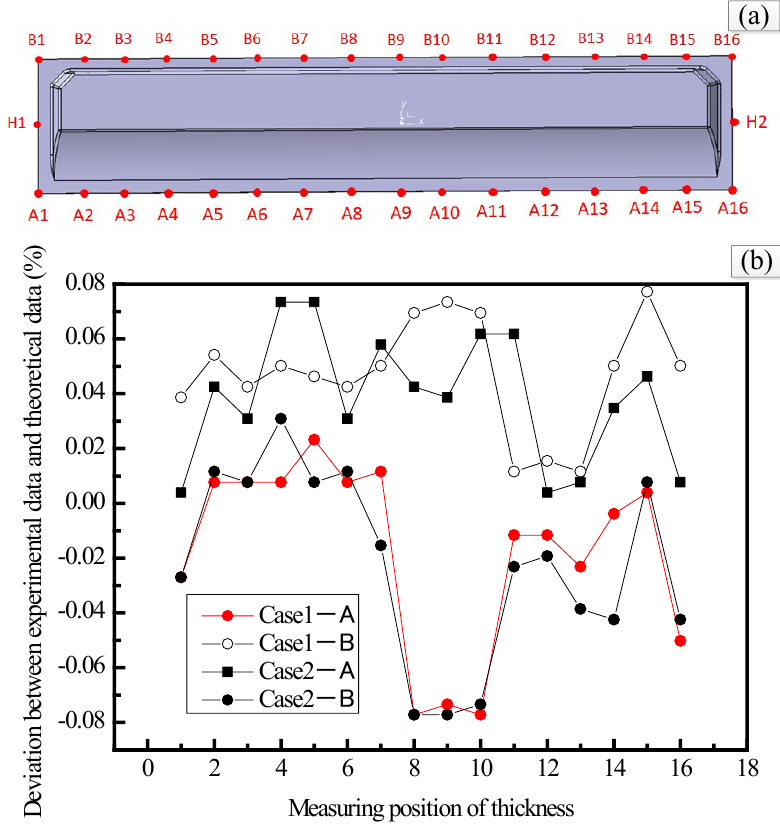
Figure 14. Thickness distribution of the spoiler under different cases. ( a ) Thickness measurement position; ( b ) thickness measurement results. position; ( b ) thickness measurement